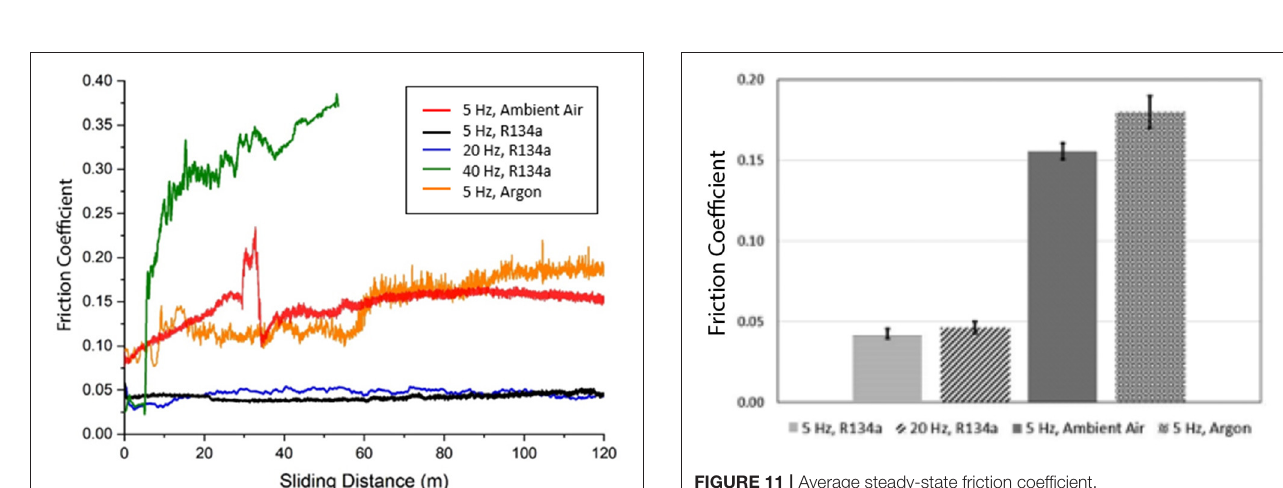
FIGURE 11 | Average steady-state friction